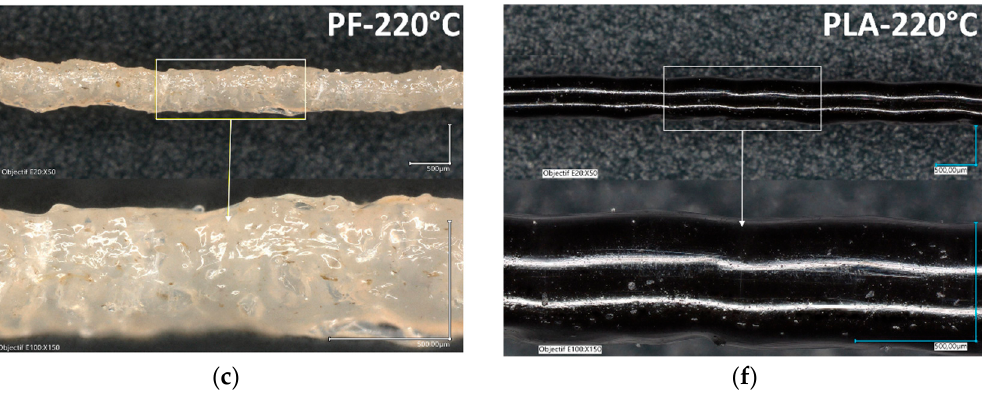
Figure 9. Filament morphology of PLA and PF after extrusion at high temperatures. ( a – c ) PF filament at 200 °C, 210 °C et 220 °C, respectively. ( d – f ) PLA after extrusion at the same extrusion temperatures.